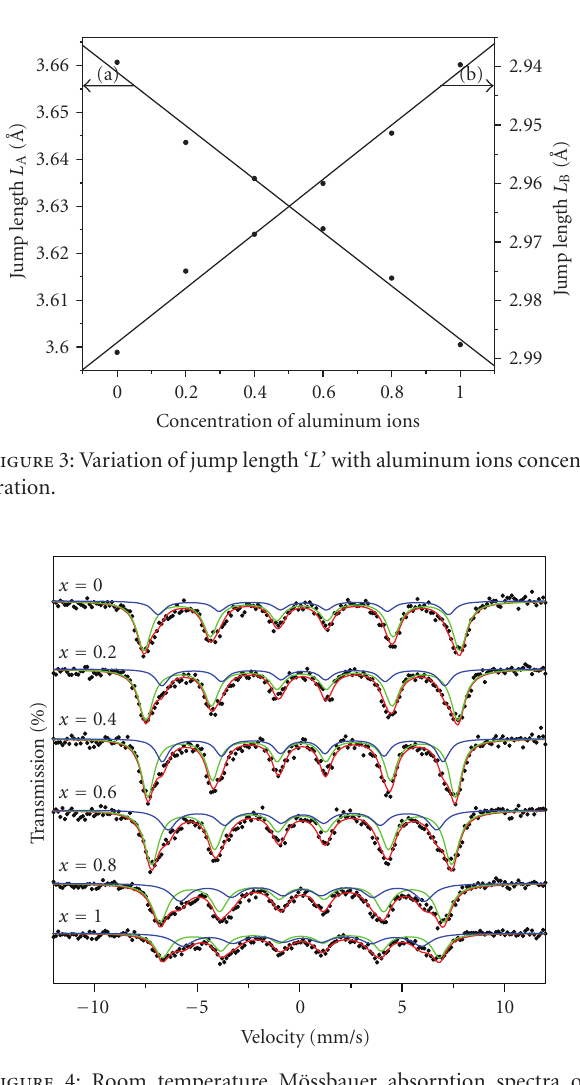
Figure 4. The experimental data were fitted using least square-fitting (NORMOS/SITE) program [36]. Each